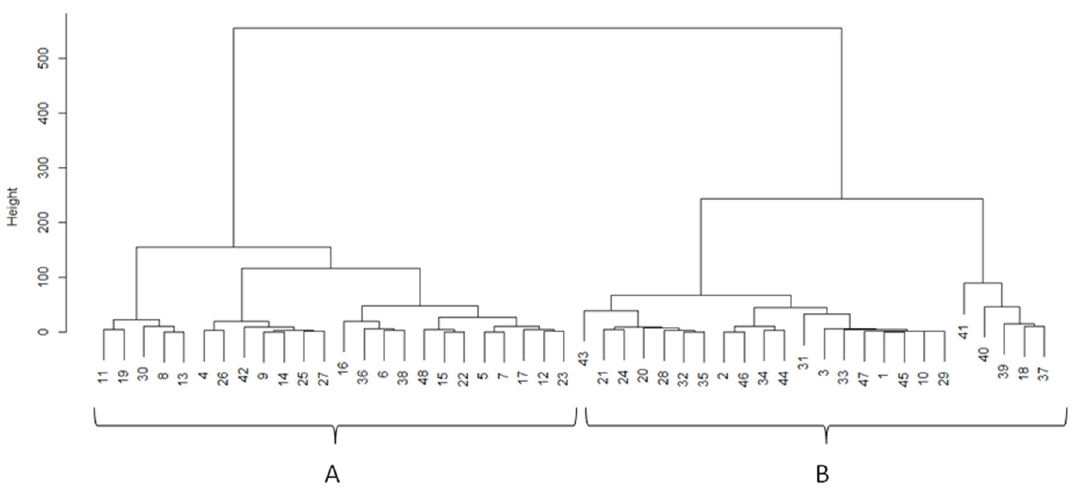
Figure 2. Cluster dendrogram obtained from PD ( n = 24) and healthy subjects from the same family ( n = 24). Cluster A includes healthy controls and mainly females with low grade of PD, while Cluster B includes mainly male PD patients with a severe grade of PD and who had a longer and stronger medication.